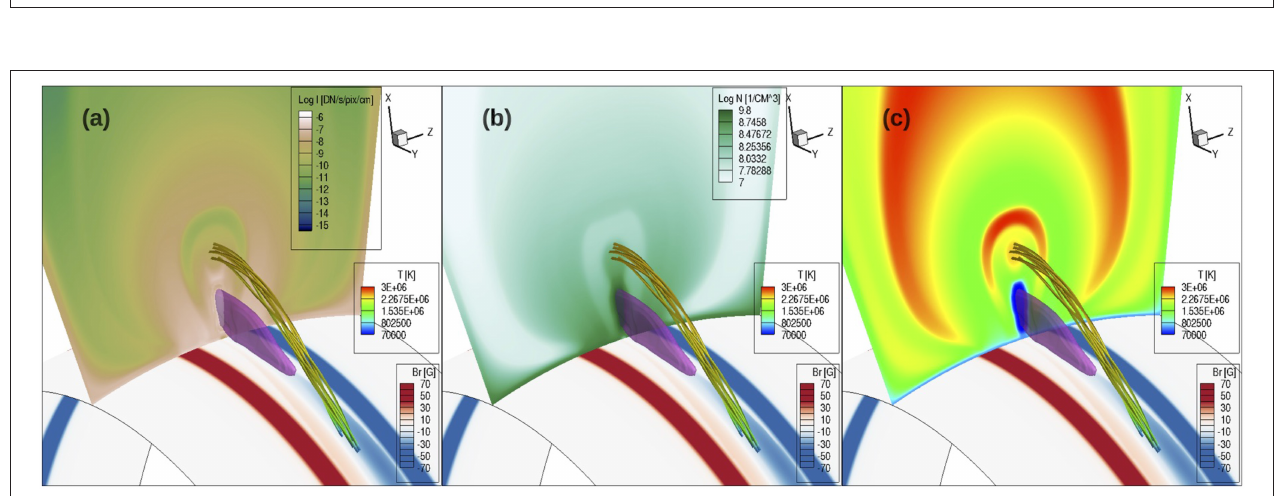
FIGURE 12 | A set of field lines threading through the central EUV cavity enclosed in the prominence horns, together with a middle cross-section showing the distribution of EUV 193 Å channel emission intensity (a) , density (b) , and temperature (c) . The field lines are colored in temperature and a pink iso-surface of temperature at T = 7.5 × 10 4 K outlining the location of the prominence condensation is also shown.